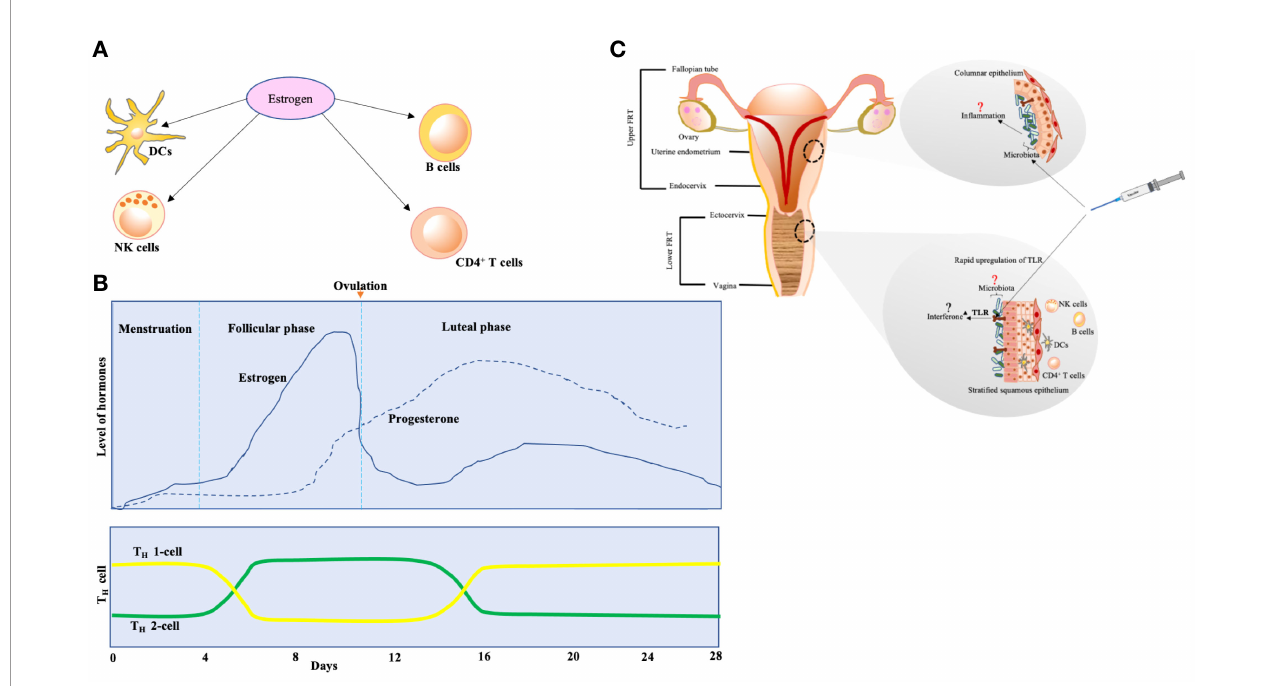
FIGURE 1 | (A) The effect of estrogen on various sentinels of innate immunity. The expression of estrogen receptors is activated on dendritic cells (DCs), natural killer (NK) cells, CD4 + T cells, and B cells. The differentiation of DCs from bone marrow is stimulated, and secretion of cytokines and chemokines by immature DCs is prompted under the effect of estrogen. B cells are encouraged to produce IgM and IgG because of estrogen. The cytotoxicity of NK cells is reduced by estrogen. (B) T-cell population variation according to estrogen and progesterone levels over the span of various phases of 28-day menstrual cycle. The effect on T cells is biphasic — higher estrogen levels (seen during follicular phase of menstrual cycle) encourage polarization of TH-2 cells (these cells actively participate in allergic reactions and drive B-cell class switching for IgE production that arms the effector cells, mast cells, and basophils), whereas lower estrogen levels (seen during luteal phase and menstruation) prompt differentiation of TH-1 cells (these are critical in clearance of invading pathogens but exaggerated stimulus associates with autoimmune diseases). (C) The potential effect of vaccination on female reproductive tract (FRT). Upper FRT: endometrium seems to dock a relatively unique microbiota with lesser biomass (19). The microbiota may be modulating the events of in fl ammation in endometrium. Lower FRT: the vaccine might be eliciting rapid upregulation of TLR in the lower FRT mucosa, which could potentially lead to interferon activation. This mechanism was seen in yellow fever virus vaccine, that led women to respond strongly as compared to men {reviewed in (20)}. This might be one of the reasons behind adverse events after vaccination in